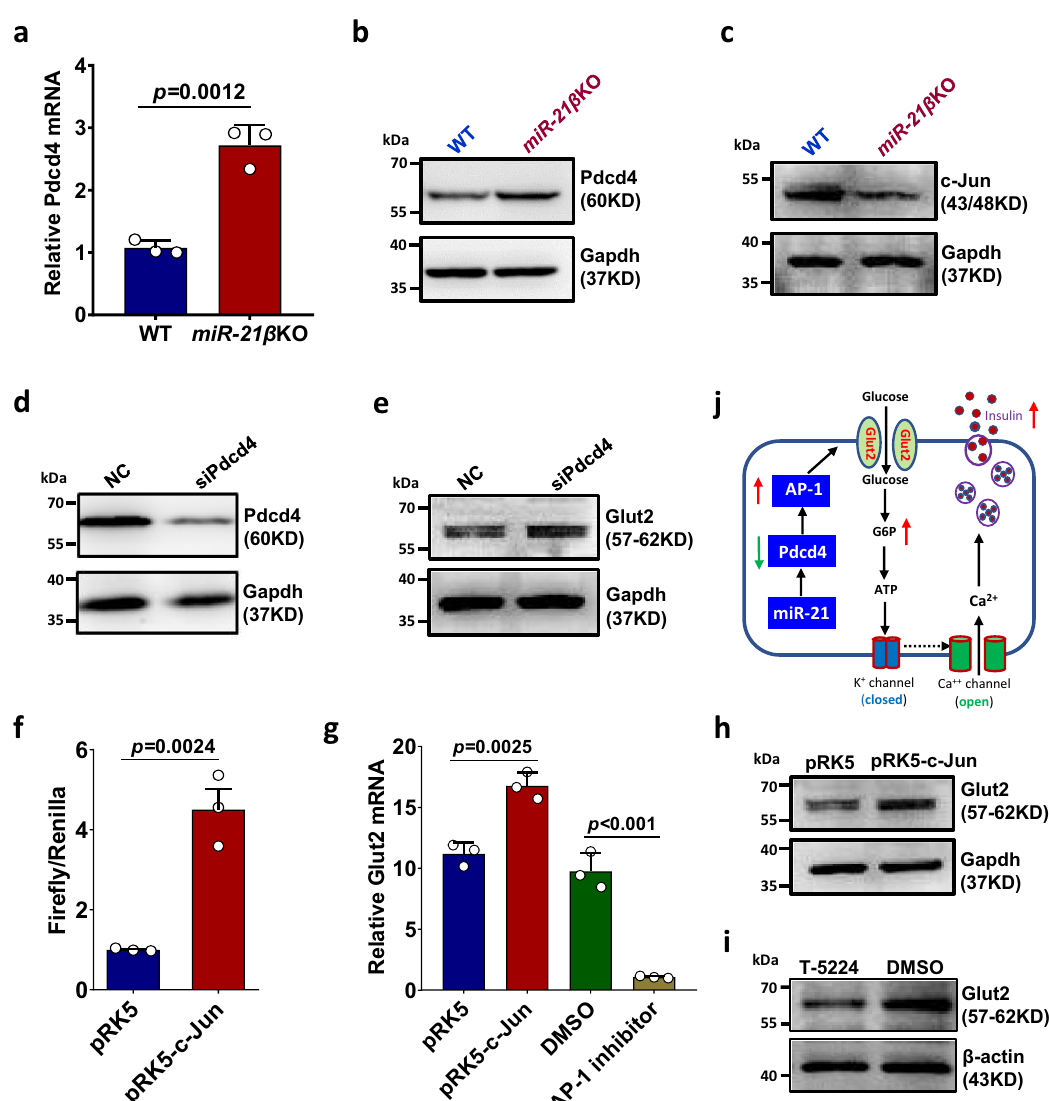
Fig. 6 miR-21 promotes Glut2 expression through miR-21-Pdcd4-AP-1 pathway. a Pancreatic islets were isolated from 7 – 8-week-old WT and miR-21 β KO mice ( n = 3). Pdcd4 mRNA expression was determined by quantitative RT-PCR. Data are presented as means ± SD for n = 3 biologically independent samples. b , c Pancreatic islets were isolated from 7 – 8-week-old WT or miR-21 β KO mice ( n = 3) and protein expression of Pdcd4 ( b ) and c-Jun ( c ) were determined by western blotting. d , e β – TC-6 cells were transfected with either universal negative control siRNA duplex (NC) or siRNA duplex targeting mouse Pdcd4 (siPdcd4). Protein levels of Pdcd4 ( d ) and Glut2 ( e ) were examined by western blotting. f β – TC-6 cells were transiently transfected with mouse Glut2 promoter luciferase reporter together with c-Jun expression vector (pRK5-c-Jun) or empty vector (pRK5). The luciferase activities of total cell lysates were measured using the Dual-Luciferase Reporter Assay system. Co-transfection of the Renilla luciferase expression vector pRL-TK was used as an internal control. g β -TC-6 cells were transfected with c-Jun expression vector (pRK5-c-Jun) or empty vector (pRK5). Alternatively, β -TC-6 cells were treated with DMSO or AP-1 inhibitor T-5224. Glut2 mRNA was determined by quantitative RT-PCR. For both ( f ) and ( g ), data are presented as means± SD for n = 3 biologically independent samples. h β -TC-6 cells were transfected with c-Jun expression vector (pRK5-c-Jun) or empty vector (pRK5). Glut2 protein level was determined by western blotting. i Pancreatic islets were treated with DMSO or AP-1 inhibitor T-5524 and Glut2 protein level was determined by western blotting. j Schematic illustration of how miR-21 promotes Glut2 expression in islet β cells. All statistical signi fi cance was analyzed using two-sided unpaired t test and P values are indicated in the fi gure. All results are representative of at least two independent experiments. Equal numbers of male and female mice were used in two genotypes. Source data are provided as a Source Data fi